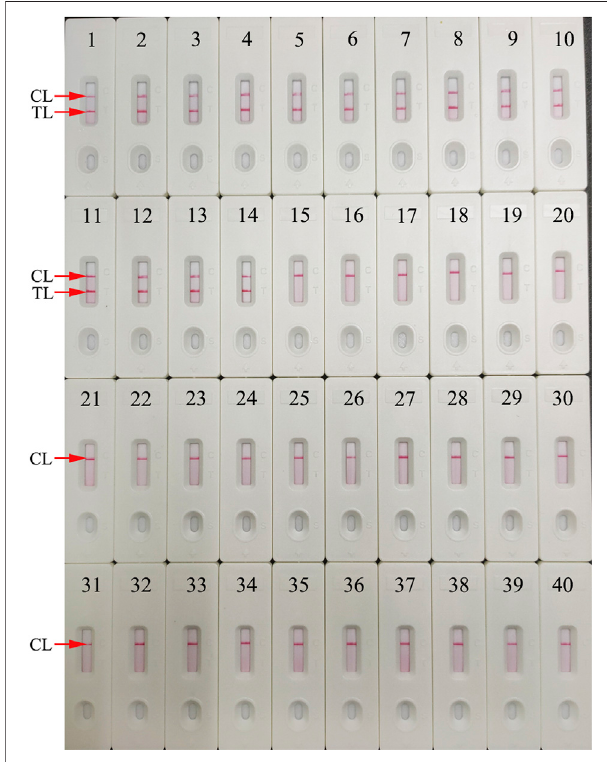
FIGURE 8 | Speci fi city analysis of the HBV-LAMP-LFB assay using different pathogens. The LAMP reactions were carried out with different genomic RNA/DNA as templates, and each of the ampli fi cation products was determined by means of the visual LFB method. Biosensor 1, HBV (standardsubstance);Biosensors2 – 14,HBV(clinicalsamples);Biosensor15, HCV (standard substance); Biosensor 16, HIV (standard substance);